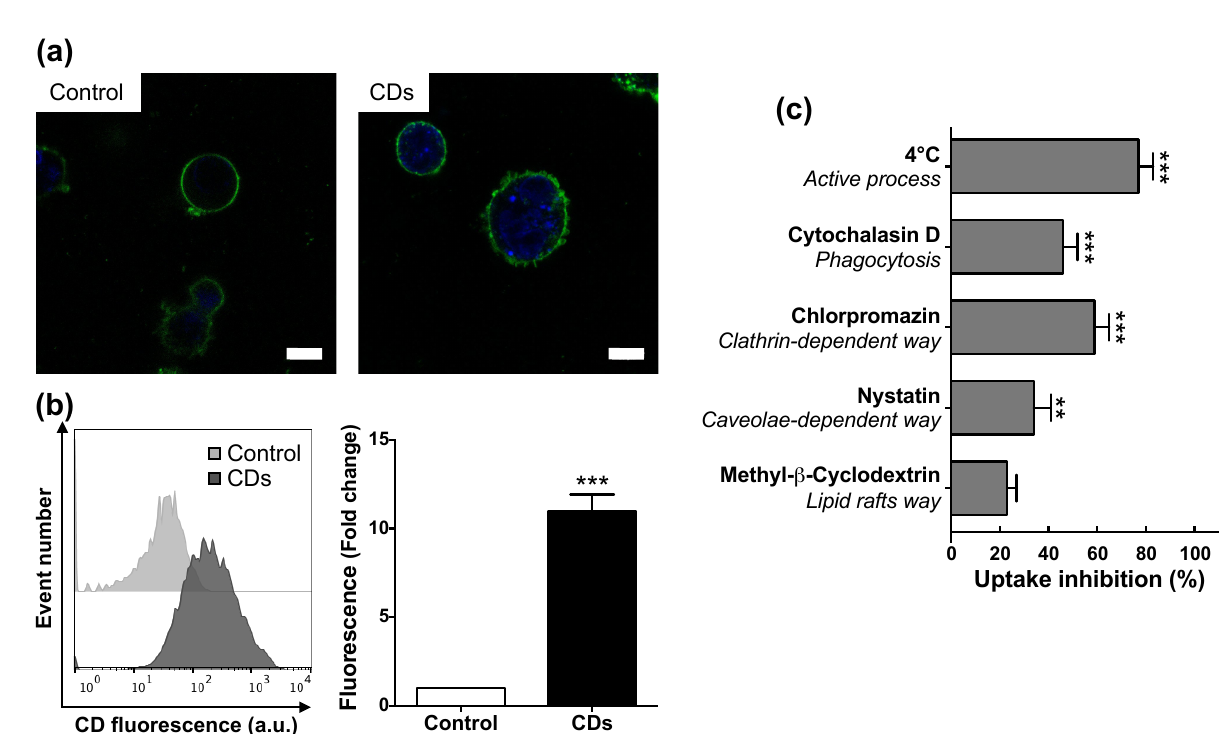
Figure 5. Uptake of CDs in cultured macrophages as assessed by CLSM or FACS. ( a ) CLSM analysis of unexposed cells (left) or cells exposed to 25 µ g/mL of CDs for 4 h (right). Cells were stained with the fluorescent membrane probe DSQ12S before observation. Cell membrane is colored in green and CDs appear in blue (scale bar = 10 µ m). ( b ) Quantification of CD internalization by FACS. Results are expressed as fold change in fluorescence intensity when compared to control cells and are means ± SEM of n = 9 experiments. Statistical differences when compared to control were determined by Student’s t -test. *** p < 0.001. ( c ) Study of CD internalization mechanisms by FACS. Cells were pre-incubated at 4 ◦ C or pre-treated with various pharmacological inhibitors for 30 min before the addition of CDs (25 µ g/mL). Internalization was measured at 4 h. Results were expressed as percent of inhibition of CD uptake and are means ± SEM of n = 3 experiments. Statistical differences when compared to control were determined by ANOVA followed by the Dunnett’s test. ** p < 0.01; *** p <